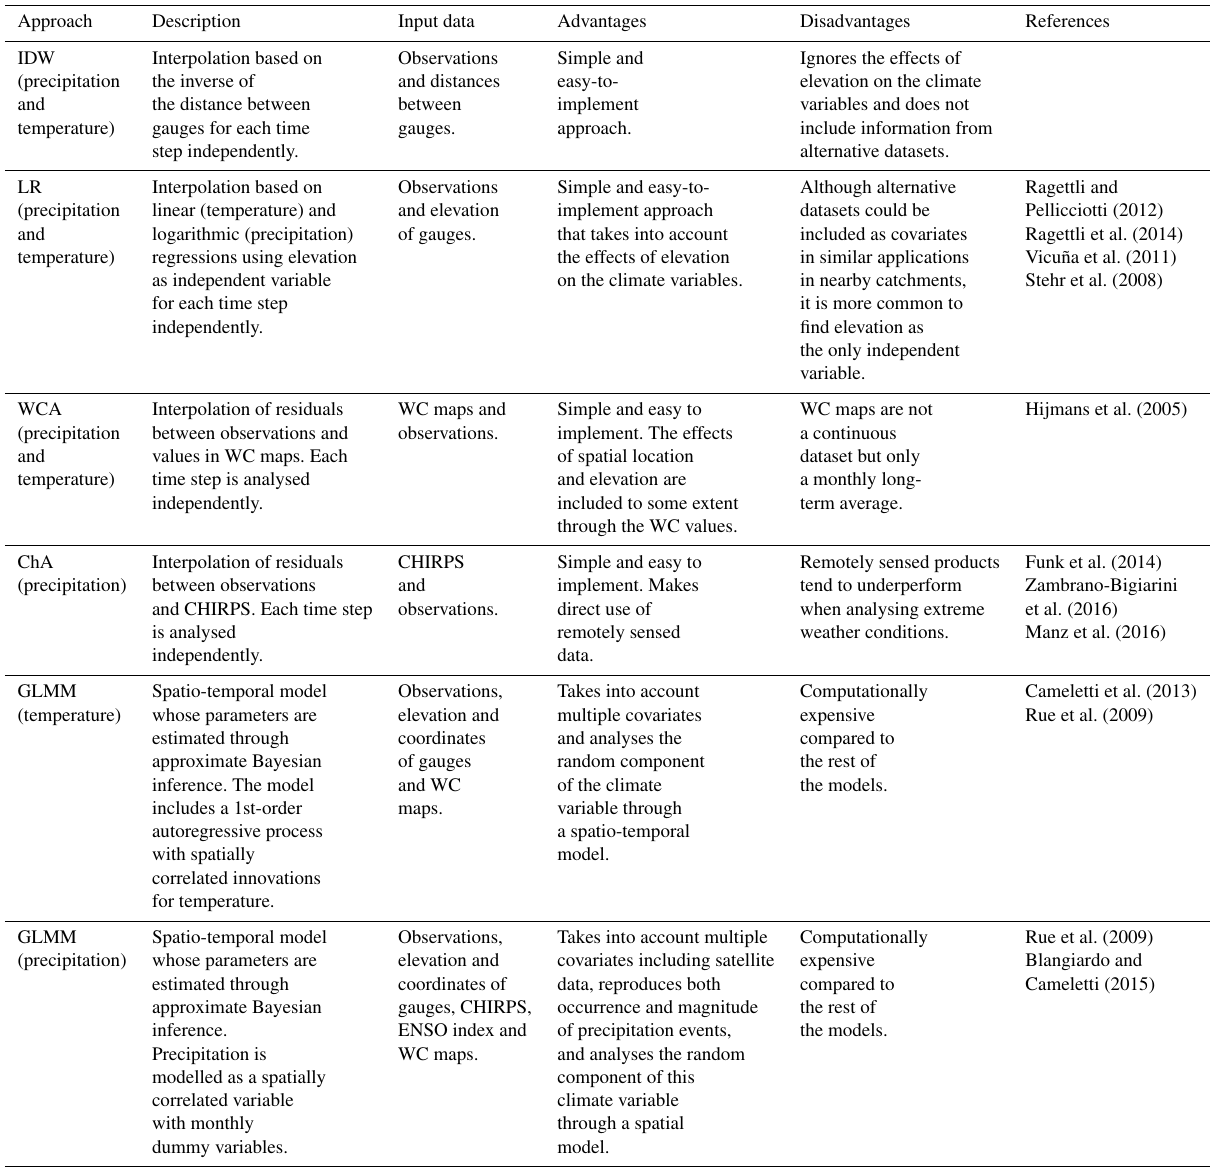
Table 1. Summary of approaches to interpolate climate variables.